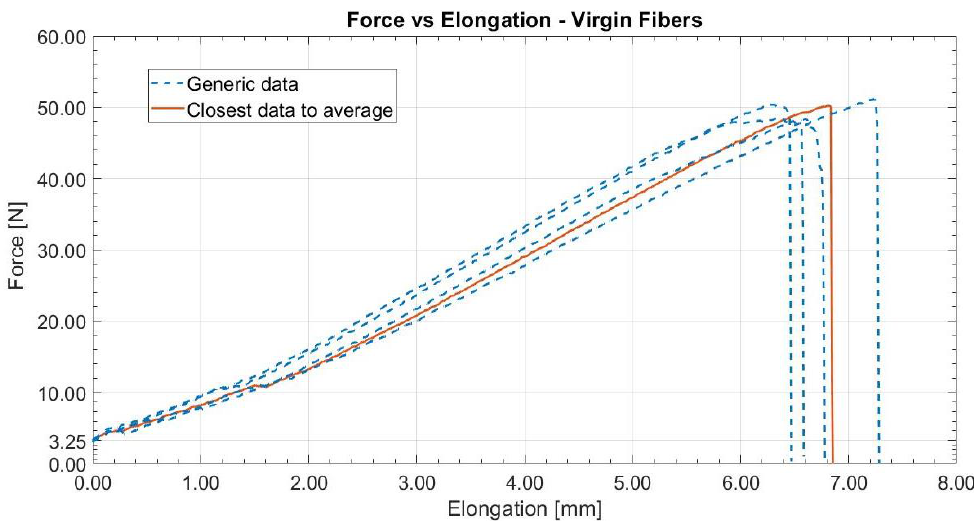
Figure 7. Force vs. Elongation curve of virgin basalt fibers.